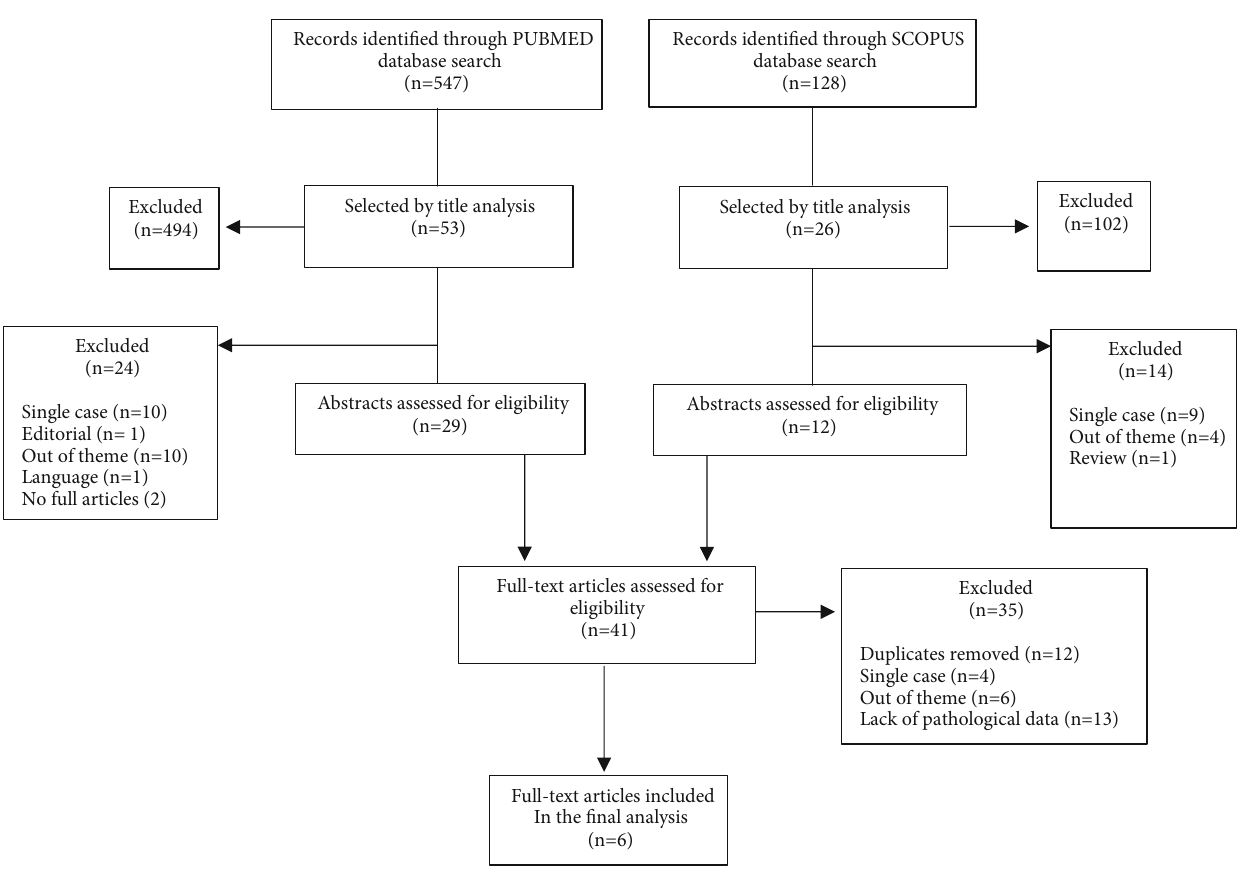
Figure 1: Search strategy. Table 1: Characteristics of the selected